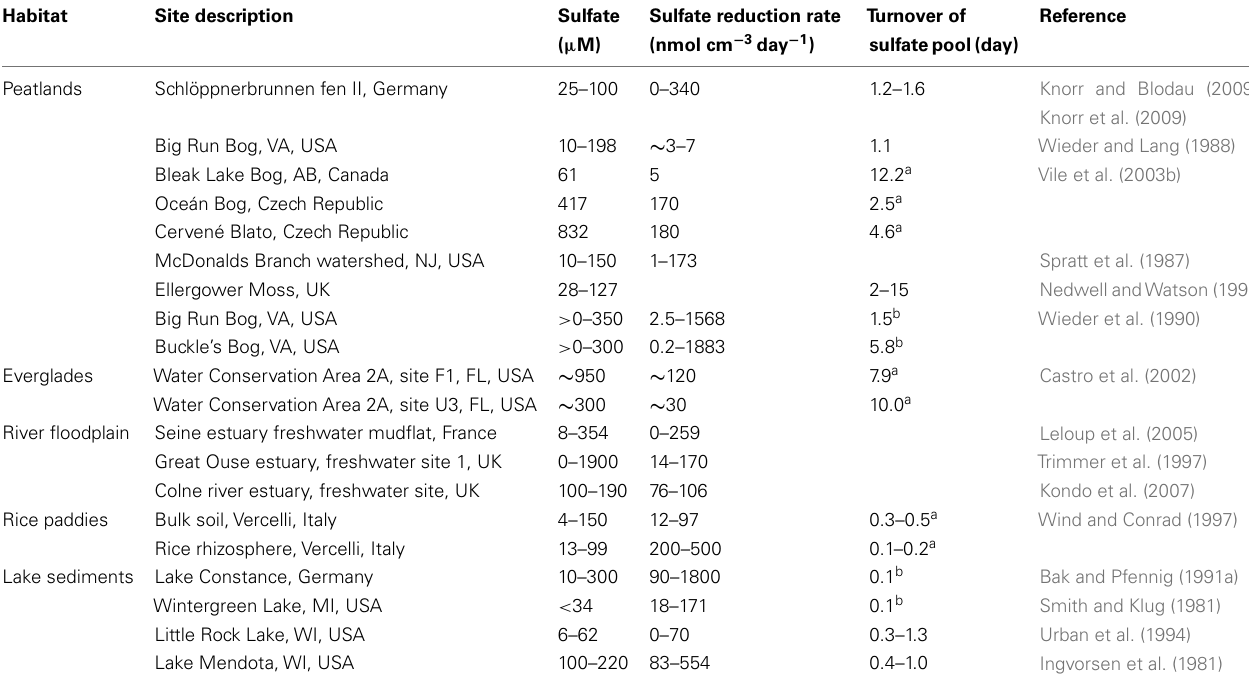
Table 1 | Summary of sulfate reduction rates in environments with low-sulfate concentrations ( μ M-range) as determined with 35 SO 2 − -radiotracer 4